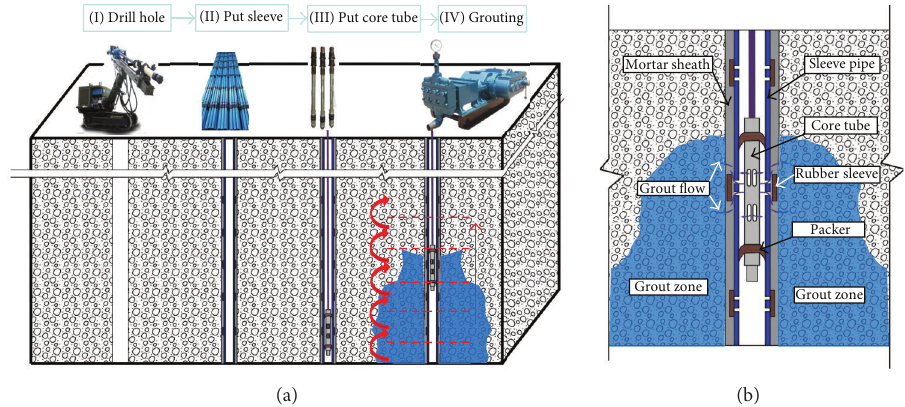
Figure 8: The grouting procedure of sleeve valve tube grouting method and its detailed composition.